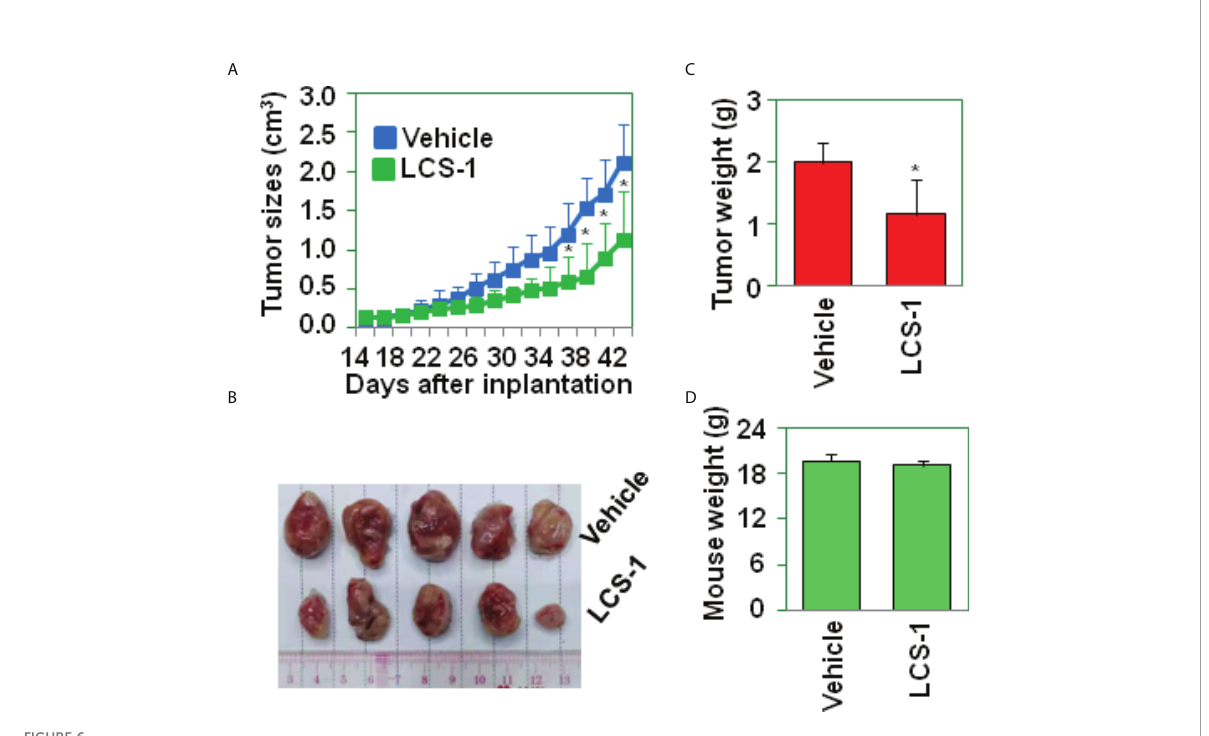
FIGURE 6 LCS-1 decreases tumor growth in nude mice. (A) Tumor growth curve from nude mice implanted with U87 cells and treated with or without LCS-1. * P < 0.05 compared with the vehicle groups. (B) Tumors from nude mice implanted with U87 cells and treated with or without LCS-1. (C) The weights of tumors from nude mice implanted with U87 cells and treated with or without LCS-1. * P < 0.05 compared with the vehicle group. (D) The weights of mice implanted with U87 cells and treated with or without